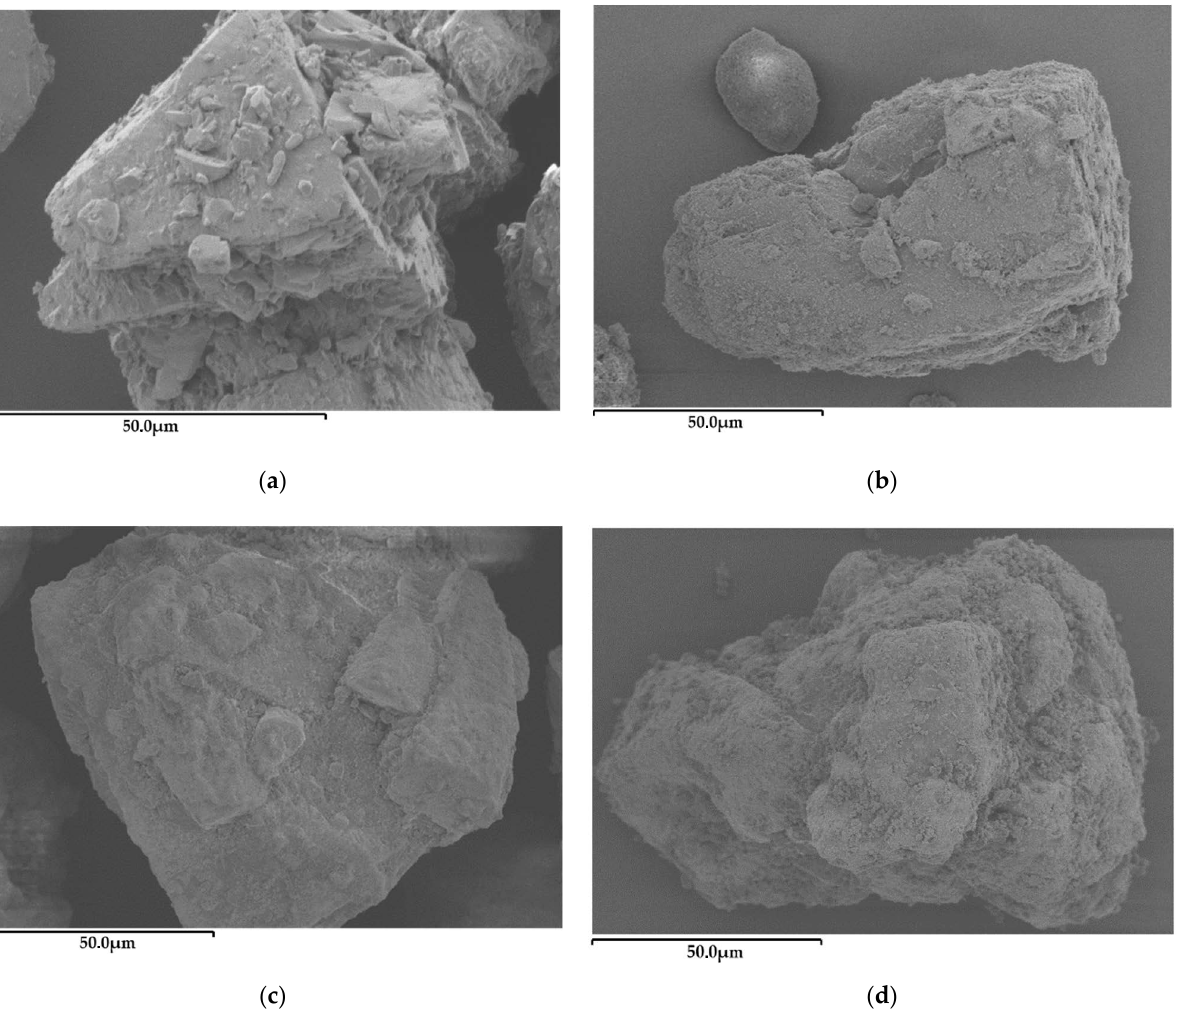
Figure 1. SEM images at 1K magnification of ( a ) unprocessed FFL particle at 1.5 K magnification and FFL host particles with 1.0% A200P; ( b ) after mixing in a V ‐ Blender and after processing in the conical mill 10 min; ( c ) at 476 rpm; and ( d ) at 1762 rpm.